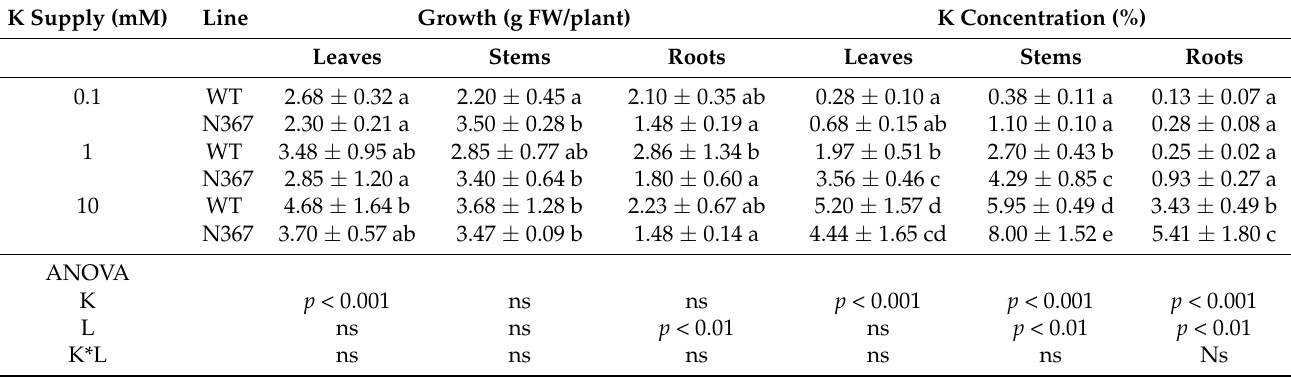
Table 3. Effects of K supply on plant growth and K concentration in different organs of two tomato lines (WT and N367) at harvest after receiving six cycles of limited watering. Means followed by the same letter are not significantly different (LSD Test, p < 0.05). K and L in ANOVA represent potassium and line factors, respectively. FW, fresh